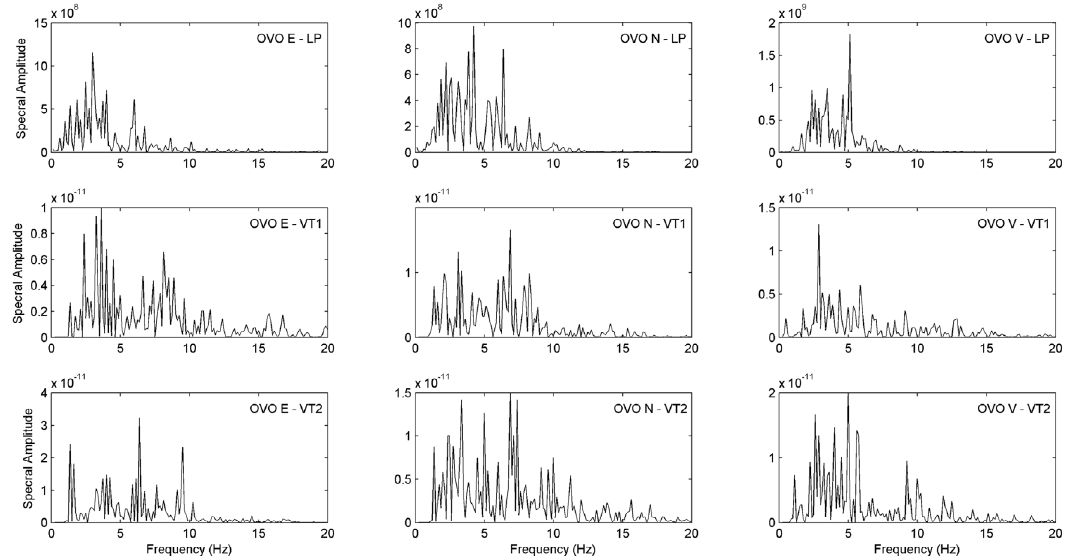
Figure 6. Spectral amplitudes vs frequency for the three analyzed events at OVO station. In the upper-right corner of each panel the event and the ground motion component are